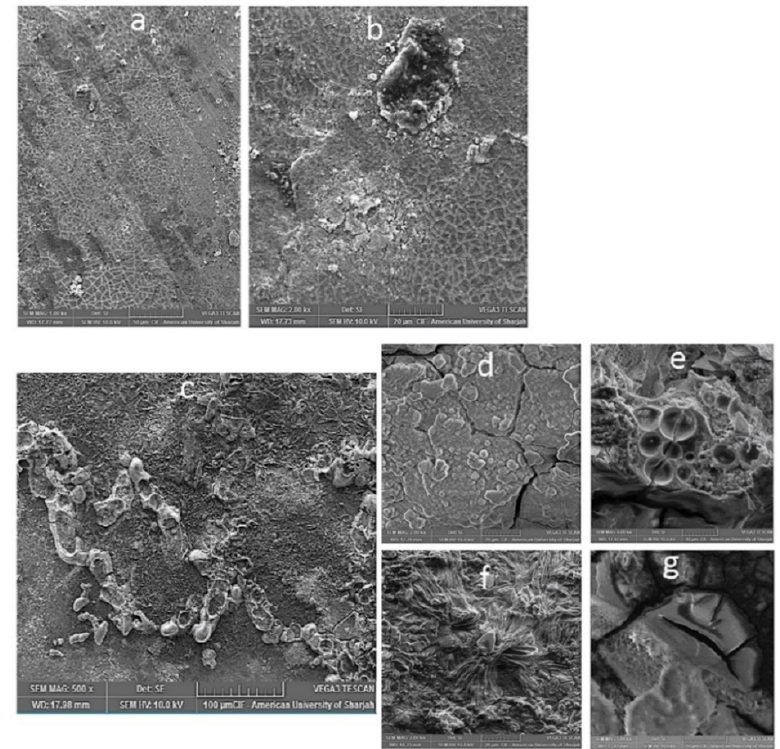
Figure 6. Micrographs depicting corrosion surface morphology. ( a , b ) Pure Mg in ASS and ( c – g ) Mg-1.0SiO 2 in ASS (in different area of sample at different magnifications).